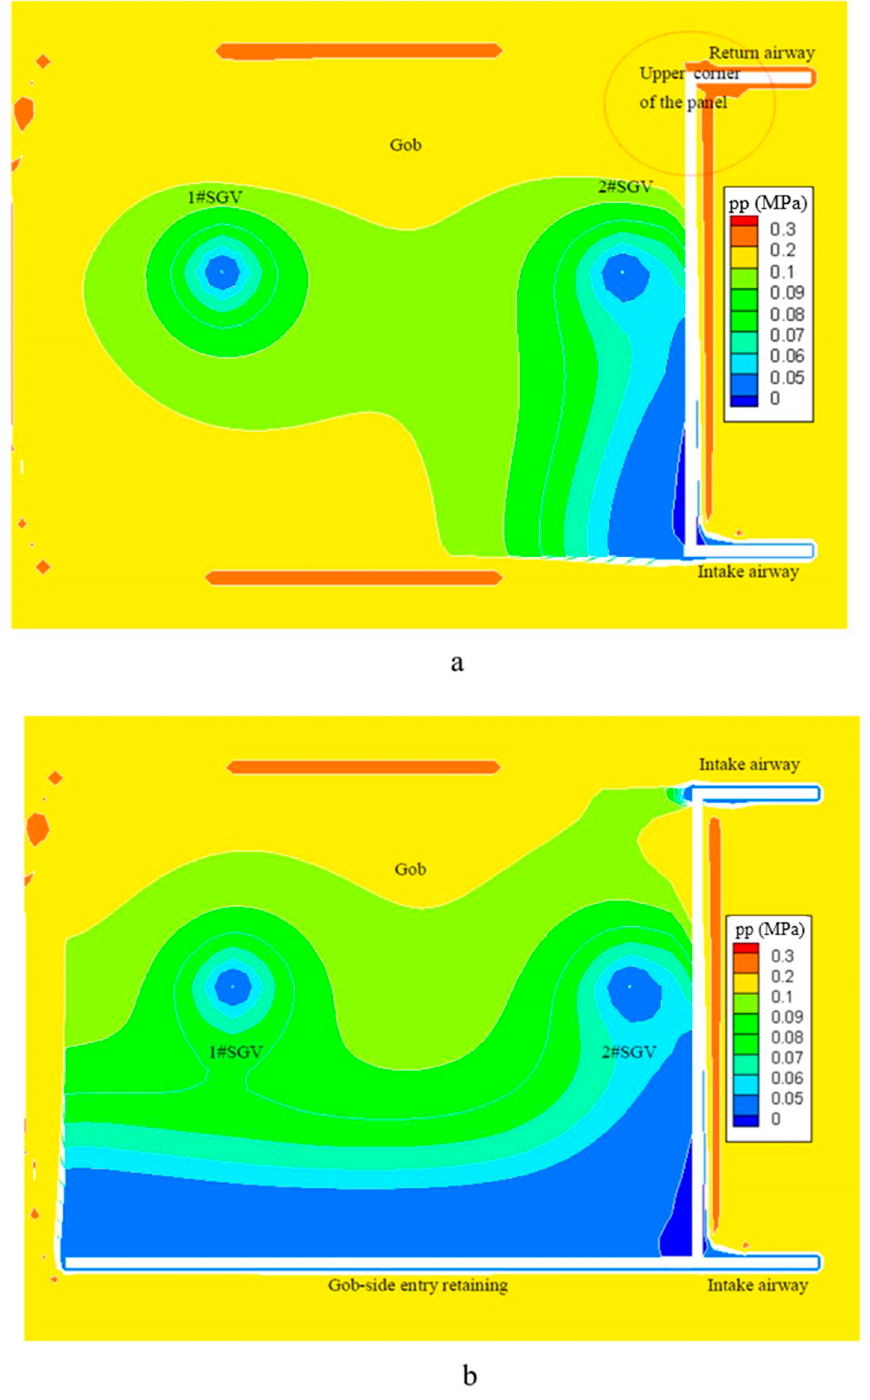
Figure 11. The gas pressure distribution in the gob with different ventilation mode. ( a ) U-type. ( b ) Y-type. ( b )